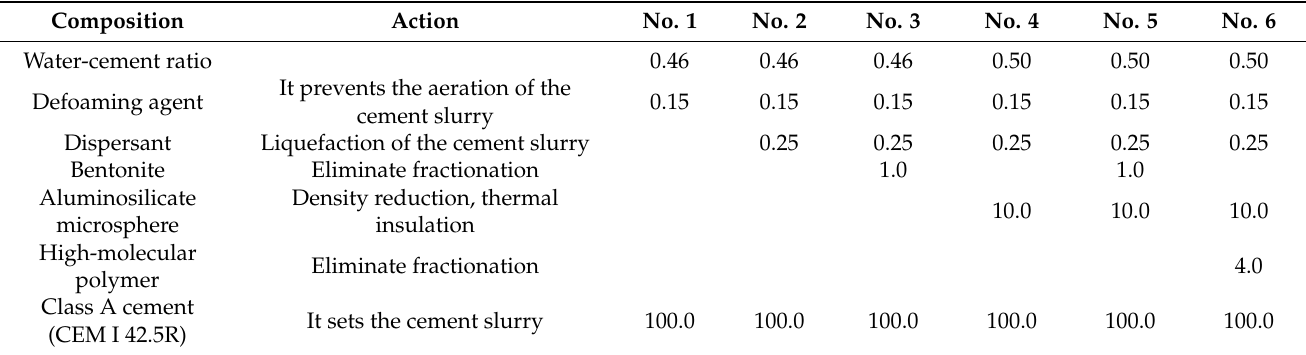
Table 1. Compositions of cement slurries based on class A cement.